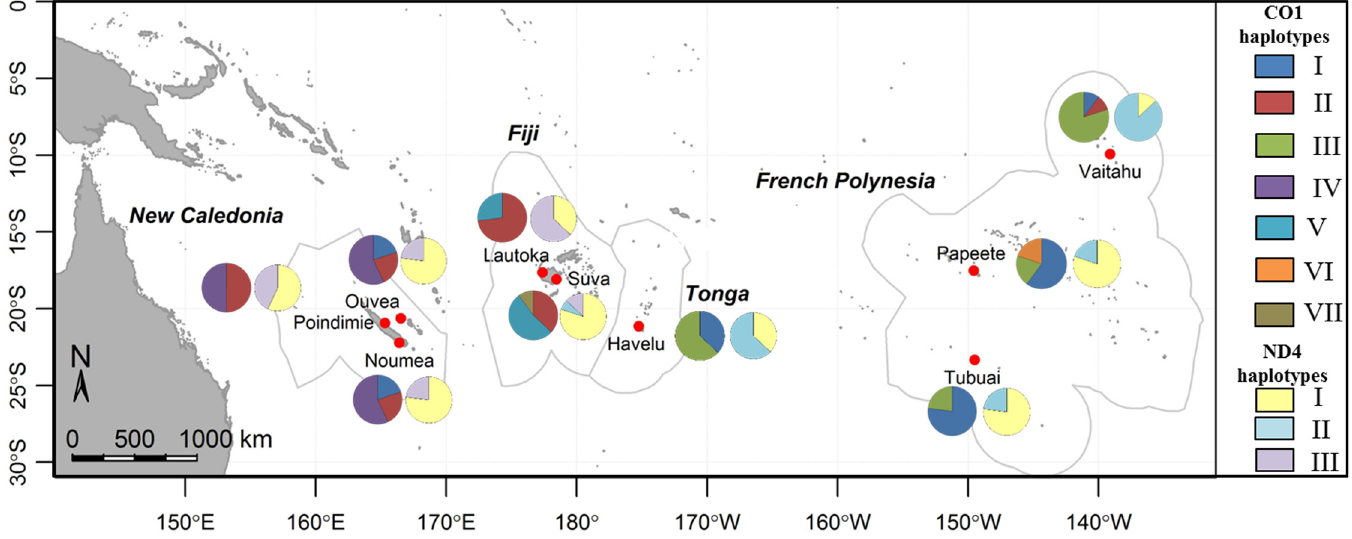
Fig 4. Representation of the MtDNA haplotype frequencies within the sample sites. The left circles indicate the CO1 haplotype frequencies and the right circles the ND4 haplotype frequencies. The arc length of each slice is proportional to the haplotype frequencies (as an example a semicircle represents 15 samples). Haplotype frequencies are indicated in S1